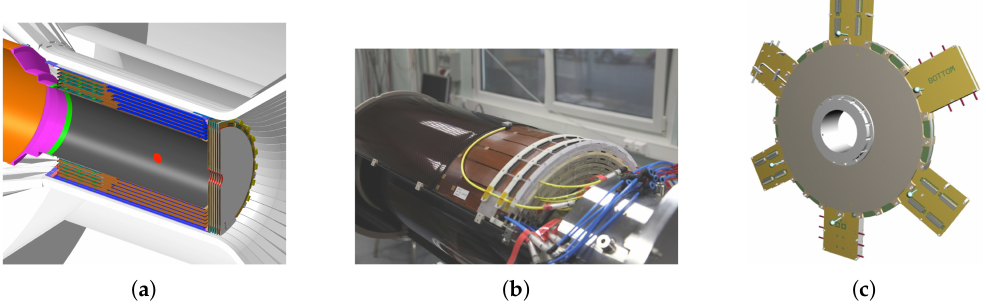
Figure 8. The CLAS12 Micromegas detectors. ( a ) Cut view of the CLAS12 Micromegas Vertex Tracker. The inner silicon detectors are not shown. The red dot highlights the position of the target. ( b ) Photograph of a full stack of six BMT layers mounted on the support structure and with the gas plumbing connected. ( c ) The CLAS12 Forward Tagger